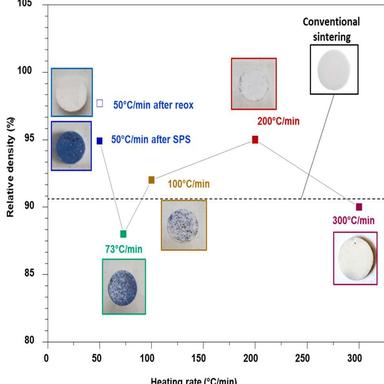
Changes in the relative density and colour of LATP pellets sintered at 750◦C during 5 min using different heating rates. The relative density obtained by conventional sintering is given by the horizontal dashed line.